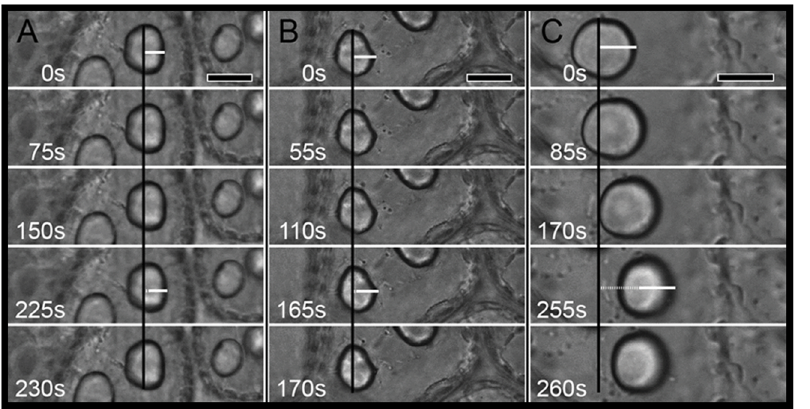
Figure 6. Corpsencerise manipulation with optical tweezers during microscopy. Control cells (A), cells from algae treated with 1 m M Lat (B) and cells from algae treated with 1.5 mM colchicine (C). The black line marks the initial CC position, and the dashed white lines mark the CC displacement. Note that no apparent displacement was observed in the cells from the control and Lat treatments, whereas in the colchicine treatment, the CC was displaced more easily, indicating that the CC is weakly adhered to the cell body when cells are treated with 1.5 mM colchicine. Bars=8 m m.